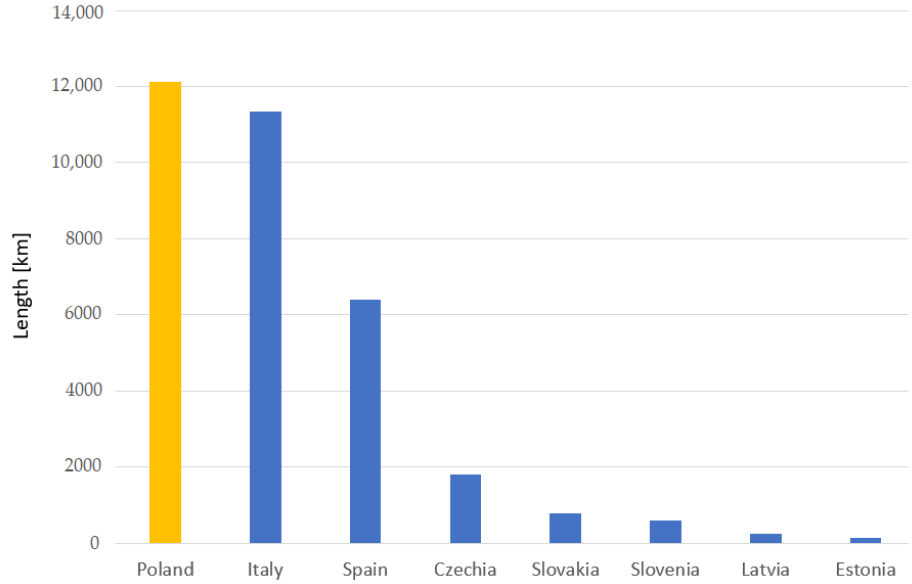
Figure 8. Correlation number of the electrified lines of rail transport relative to the type of voltage, i.e., direct current, 3000 V in 2020. Yellow colour — Poland; blue colour — other European countries.